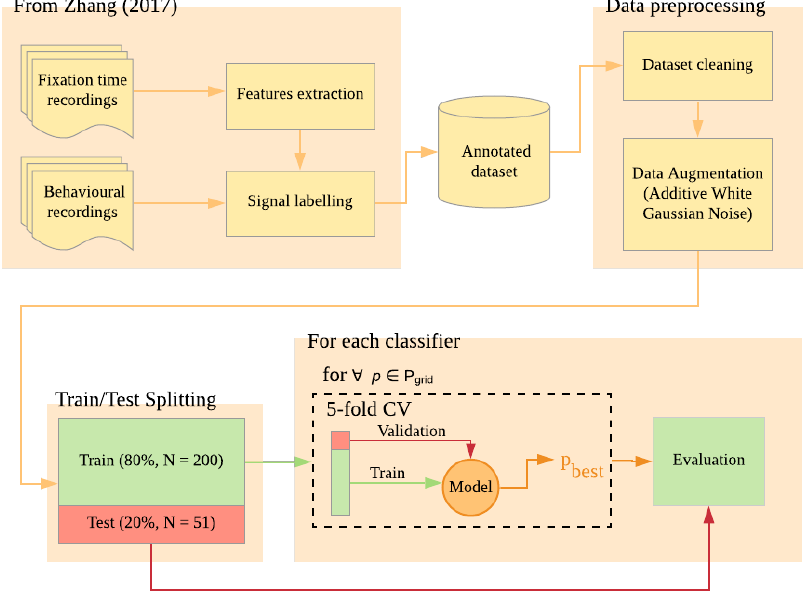
Figure 1. Summary of the steps employed for data augmentation, training, and hypertuning of the